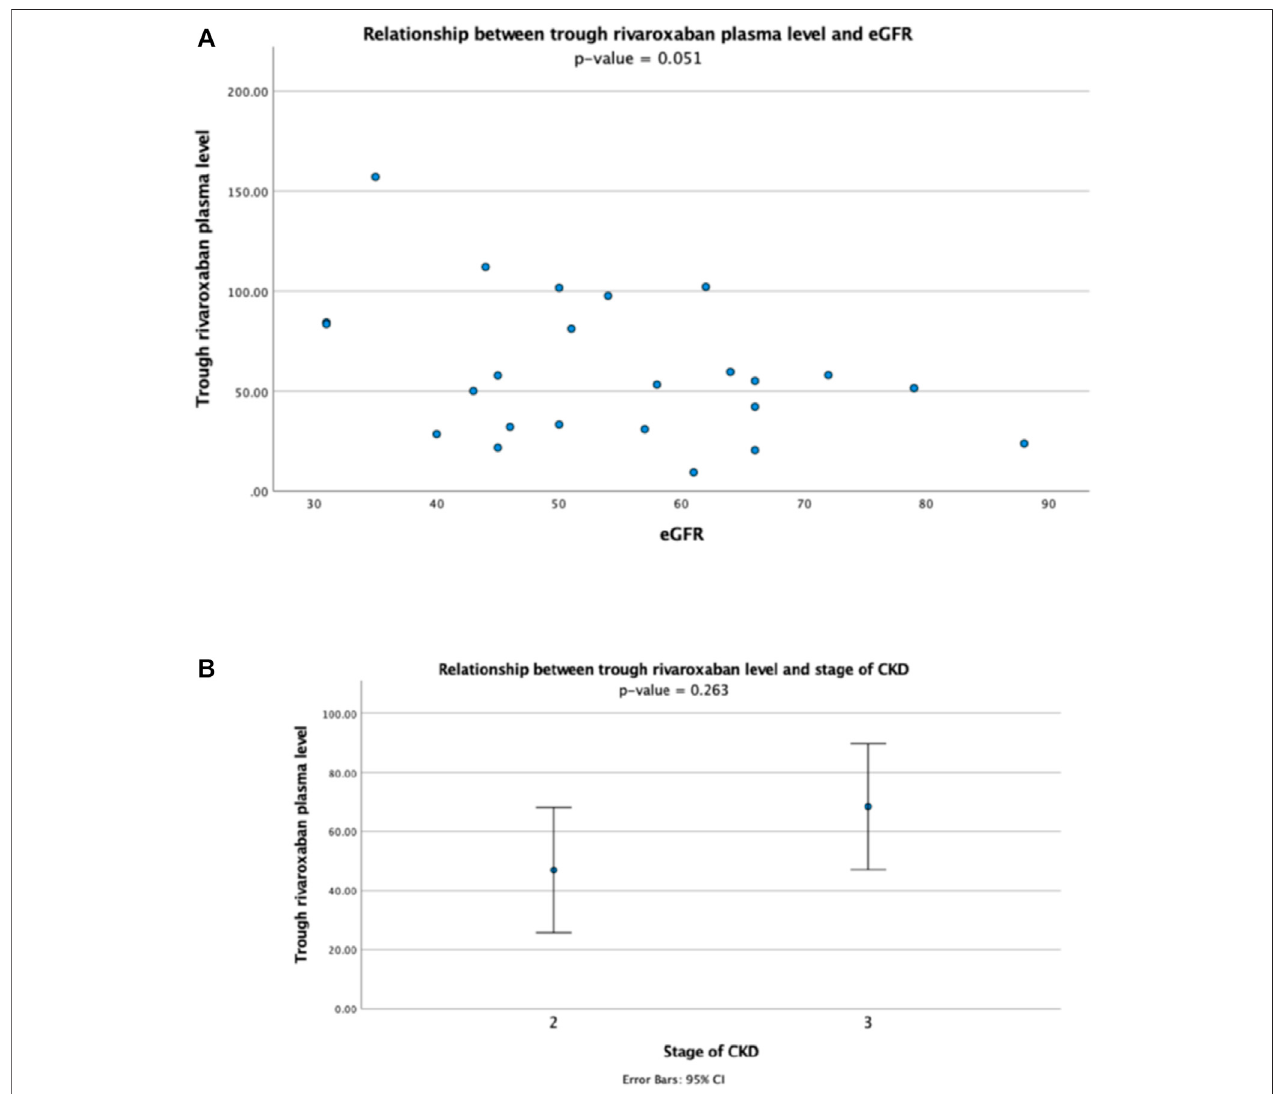
FIGURE 4 | Relationship between trough plasma rivaroxaban level and (A) eGFR and (B) stage of CKD in patients receiving rivaroxaban 15 mg once daily.